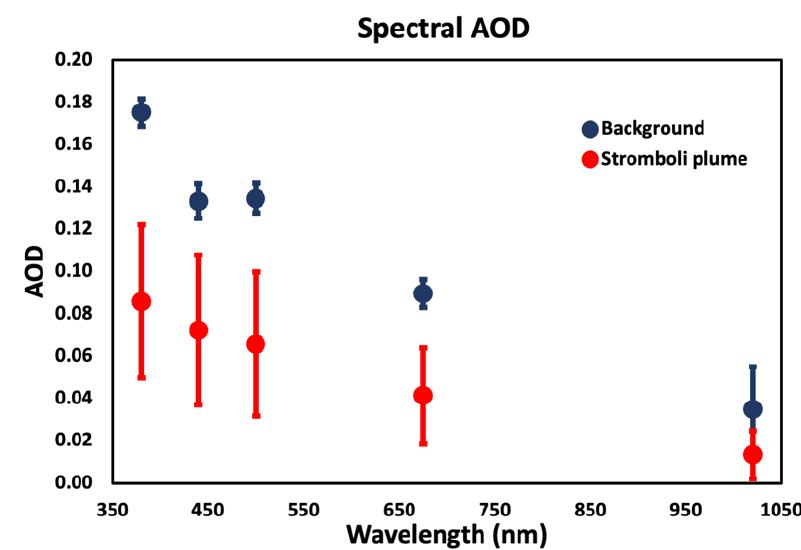
Figure 2. Average spectral AOD observations of the atmospheric background (in blue, AOD B ( λ )) and of the isolated Stromboli plume (in red, AOD P ( λ )), after the atmospheric background correction of Equation (1). The error bars of the spectral AODs represents the standard deviation of their means, linked to the AODs variability.